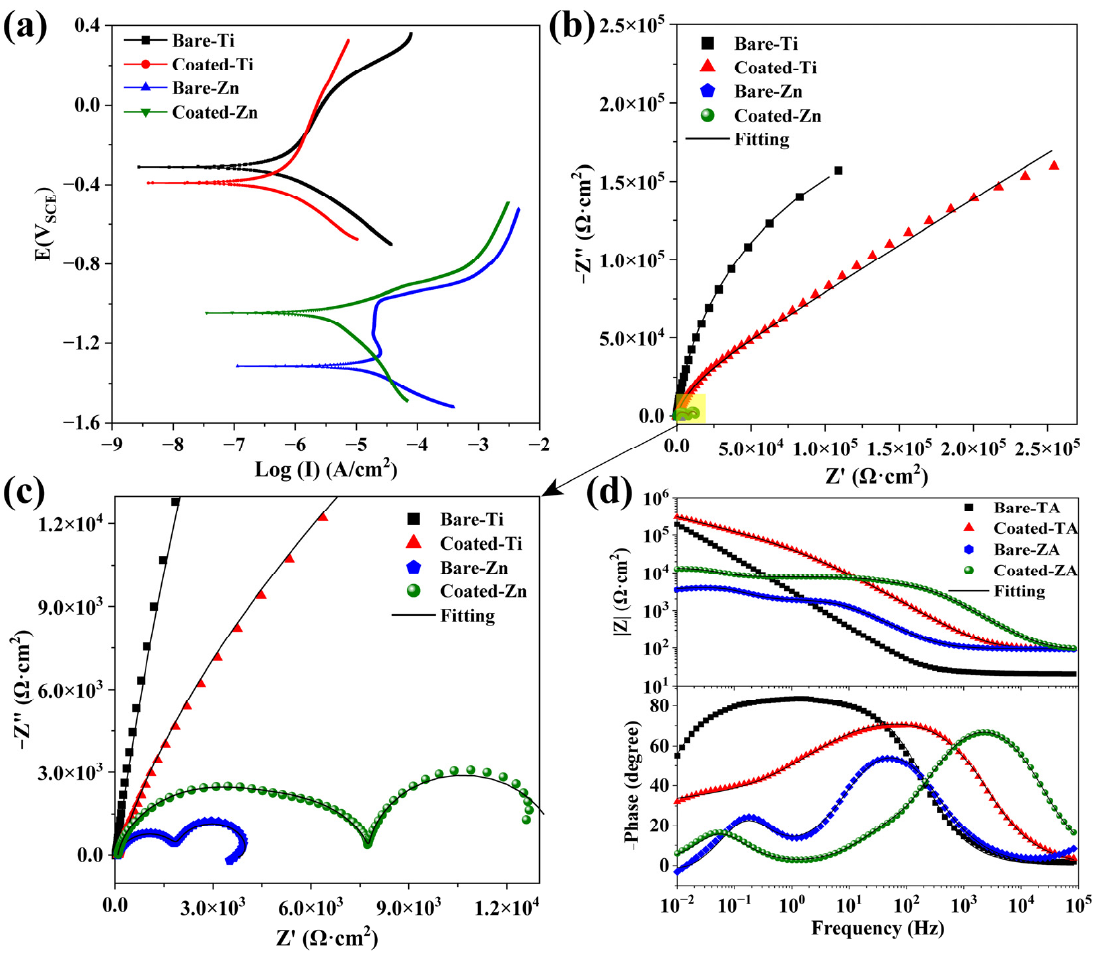
Figure 5. The electrochemical performance tests of the ZnP coatings on TA and ZA substrates. ( a ) Potentiodynamic polarization curves and impedance spectra present in ( b – d ) Bode and phase ‐ angle plots. Table 2. The electrochemical parameters determined by the polarization curves of bare and ZnP- coated TA and ZA samples. Values are shown as mean ± SD, n =